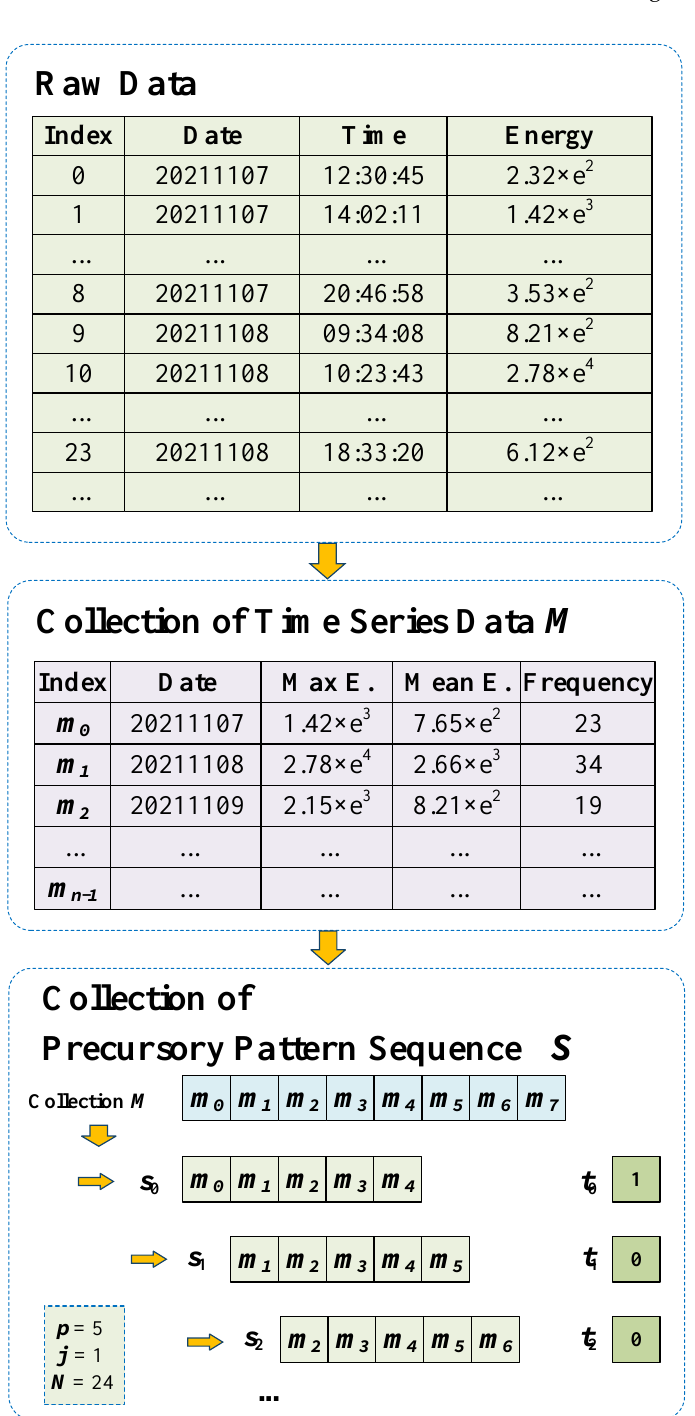
Figure 2. The workflow of data